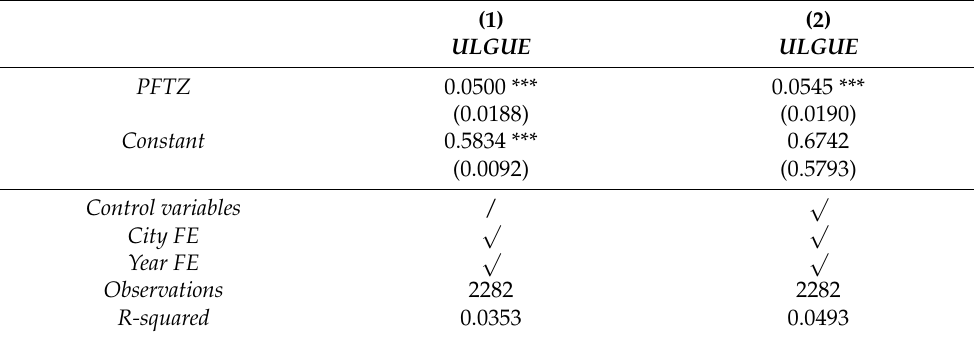
Table 4. PSM-DID estimation.